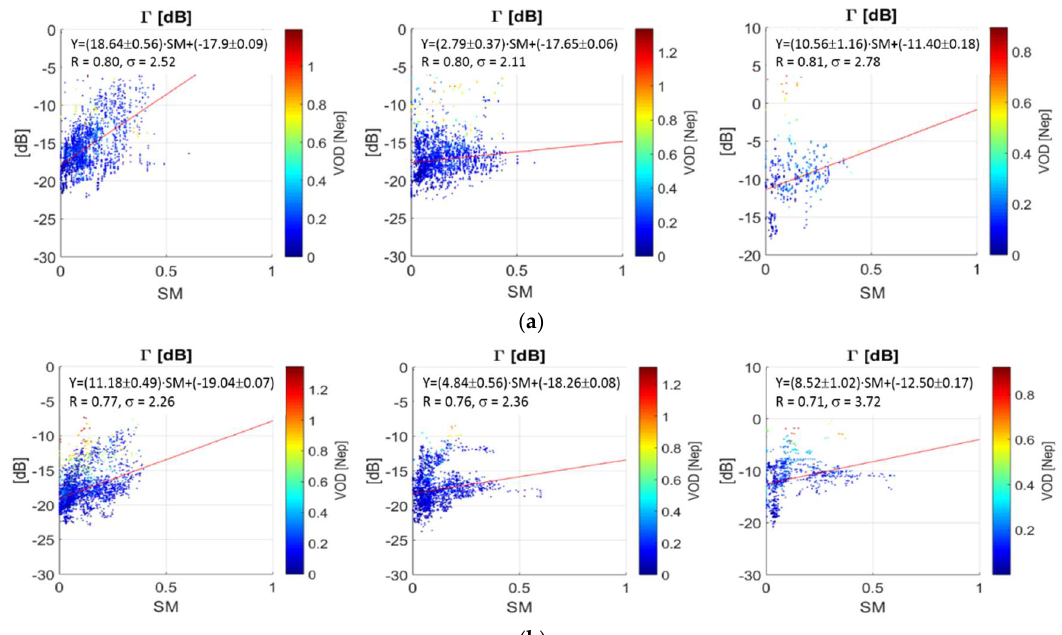
Figure 15. Scatter plot between the ( a ) Low Resolution (25 km) SMOS L3 SM and ( b ) High Resolution (1 km) SMOS L4 SM and the TDS-1 reflectivity value over Yanco/NSW/Australia from June 2016 to June 2017, with vegetation and roughness corrections applied. Each column represents the values for a specific range of incidence angles: ( left ) 0°–30°; ( center ) 30°–60°; and ( right ) 60°–90°.